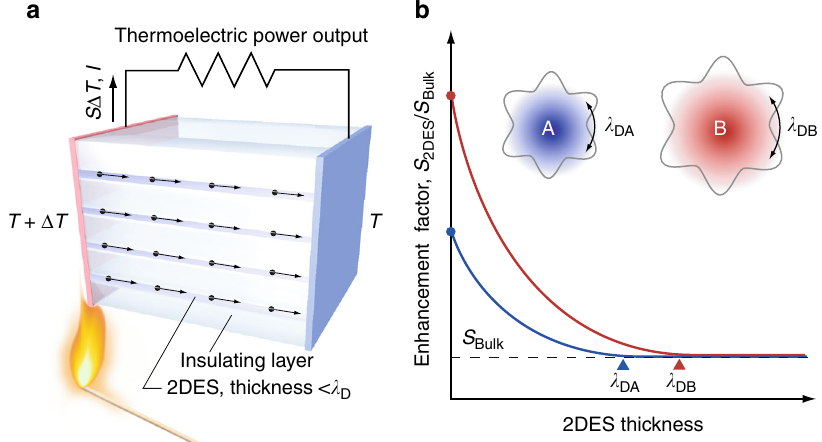
Fig. 1 Thermoelectric effect of a 2D electron system. a Schematic illustration of thermoelectric Seebeck effect in a 2DES. A thermoelectric power output ( S · Δ T · I ) can be obtained when Δ T is introduced. b The hypothesis that a 2DES with longer de Broglie wavelength ( λ D ) shows a larger enhanced factor of